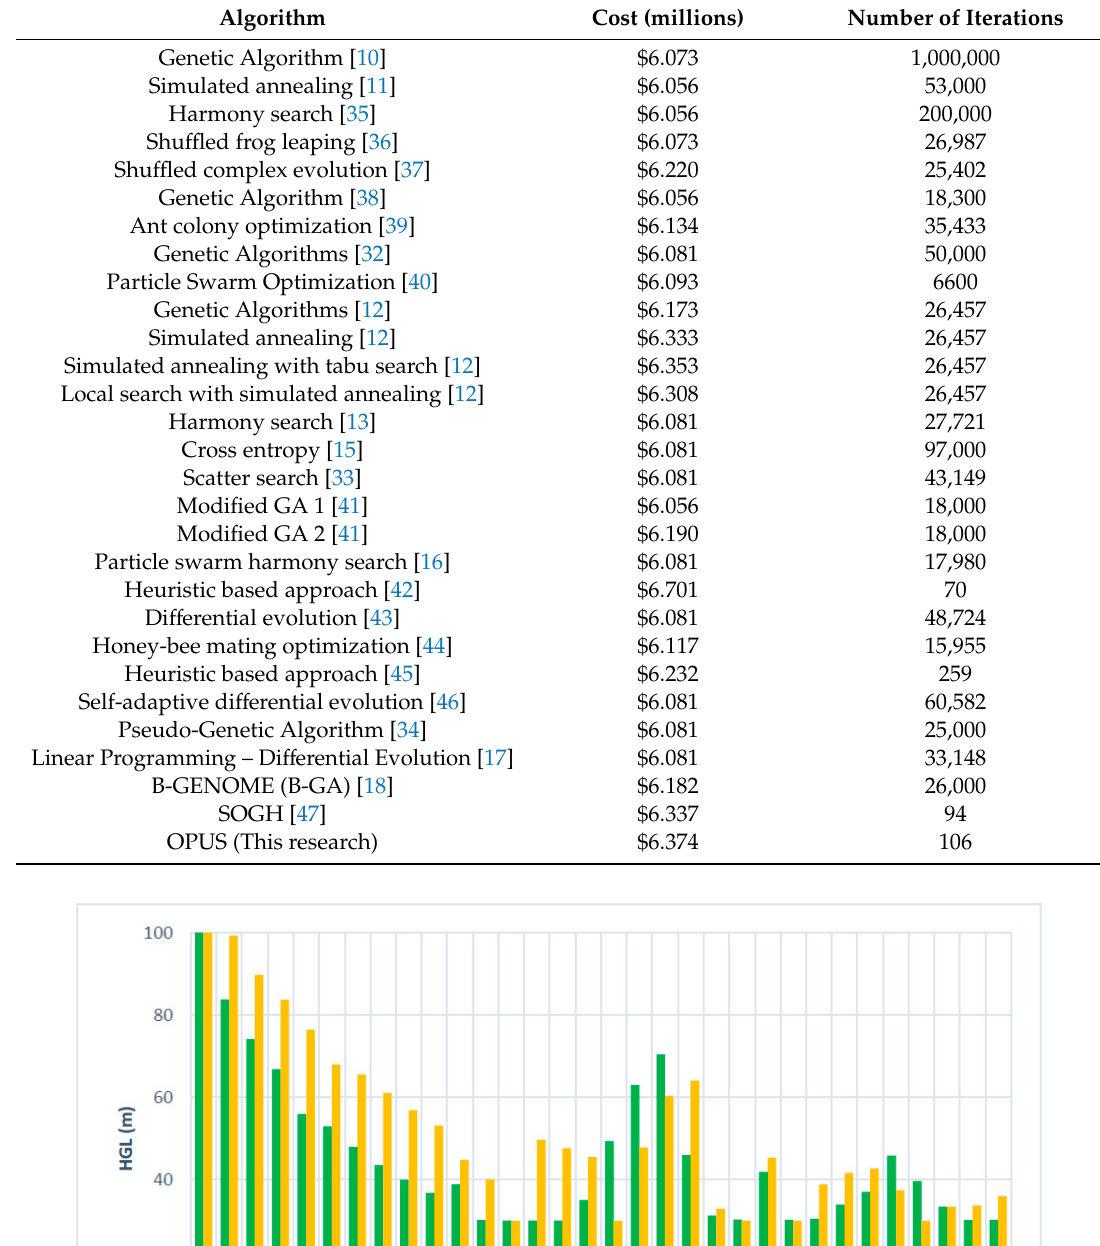
Table 2. Reported costs and number of iterations for the Hanoi WDS.